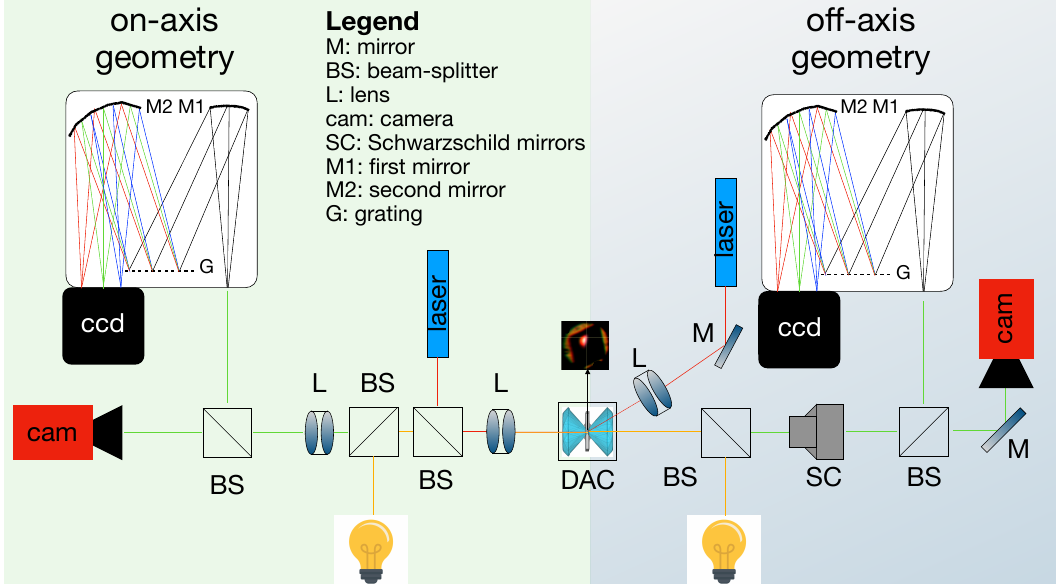
Figure 3. Concept design of a LH system showing both the on-axis geometry with lenses and the off-axis geometry, here combined with the Schwarzschild mirrors. Different color legends are used for different optical paths: red for the lasers, yellow for the illumination and green for the imaging part and temperature measurement. An actual image of a heated sample is also presented above the